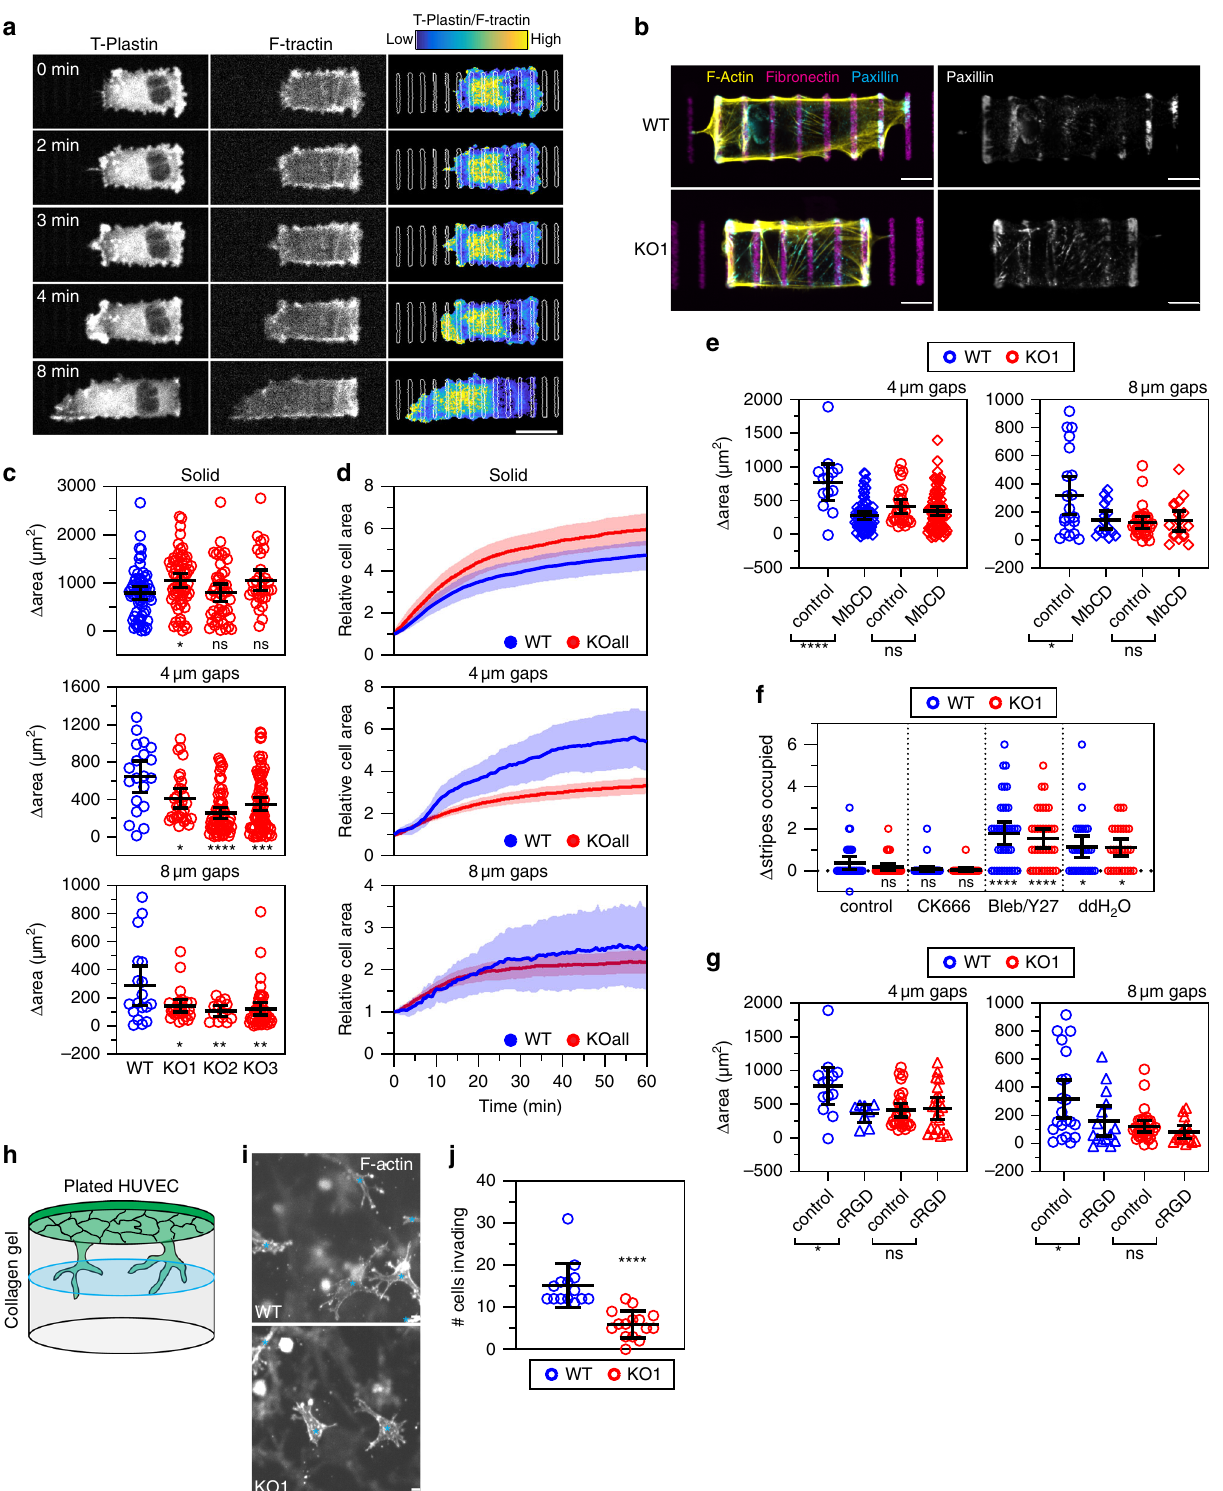
effect on KO cells (Fig. 5g, right). These results are consistent with a model that the two processes work in an epistatic manner: Integrin adhesion becomes more rate-limiting for forming new adhesion contacts after a T-Plastin-driven protrusion crosses a several-micron wide ECM gap. Altogether, our different lines of experiments show that membrane protrusion across ECM gaps can be restricted by (i)